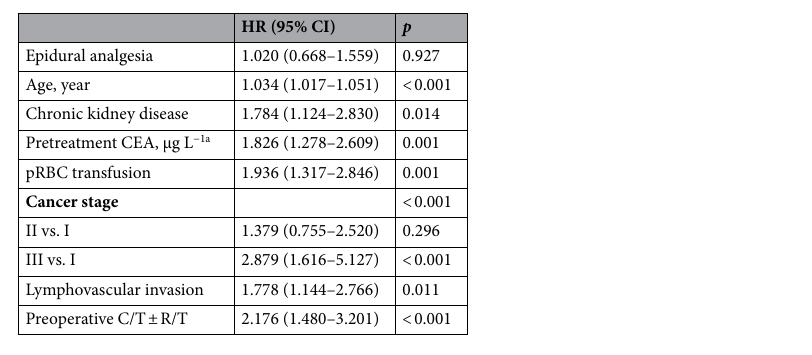
Table 3. Forward model selection for overall survival. HR hazard ratio, CI confidence interval, CEA carcinoembryonic antigen, C/T chemotherapy, pRBC packed red blood cells, R/T radiotherapy. a On base-10 logarithmic